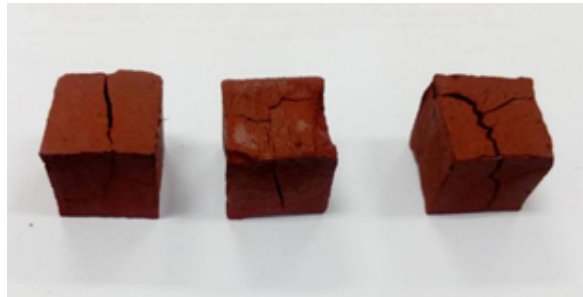
Figure 1: Binder specimens without ATA